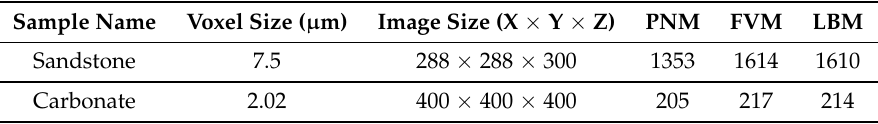
Table 2. Numerical results of the two